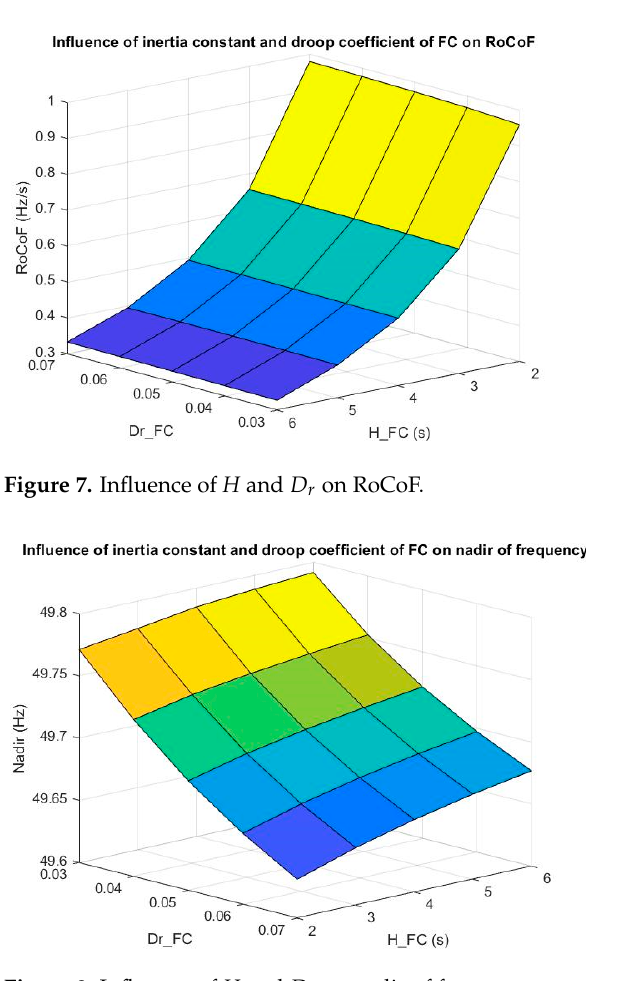
Figure 8. Influence of H and D r on nadir of frequency.